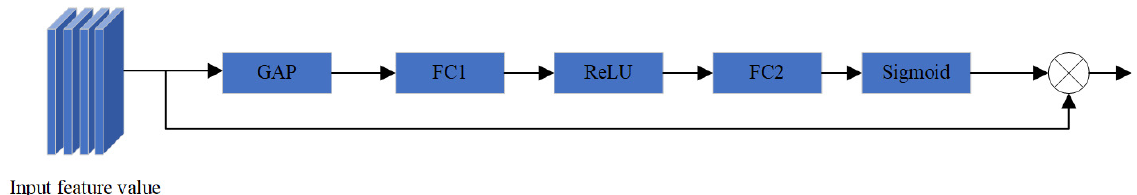
Figure 3. Channel A tt ention. Figure 3. Channel Attention.